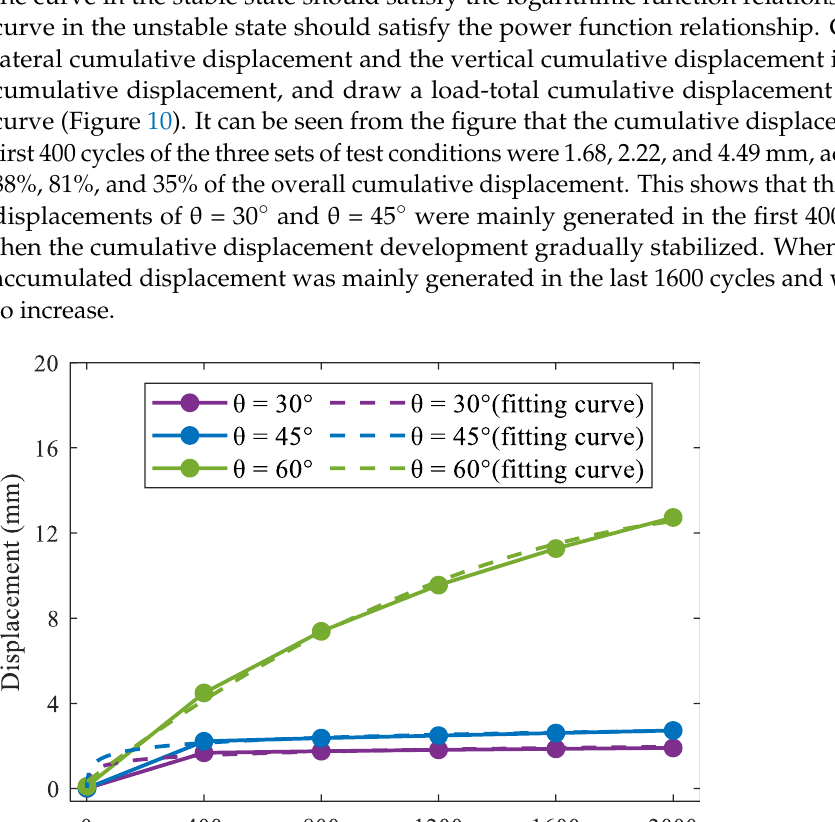
Figure 10. Cycle times – cumulative displacement relationship for variable initial tension angles.